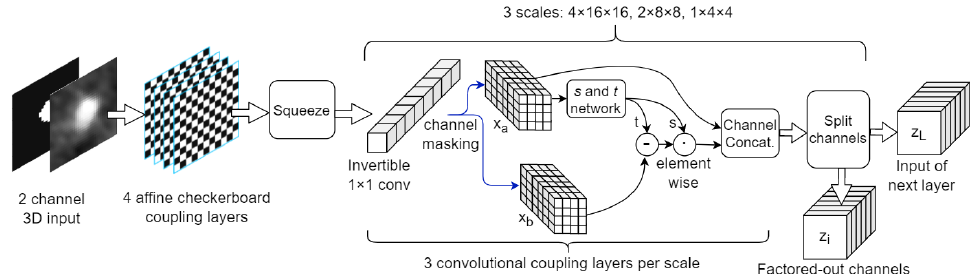
Figure 1. Baseline model architecture. Activation norm not depicted. Table 1. Glow-style baseline architecture.